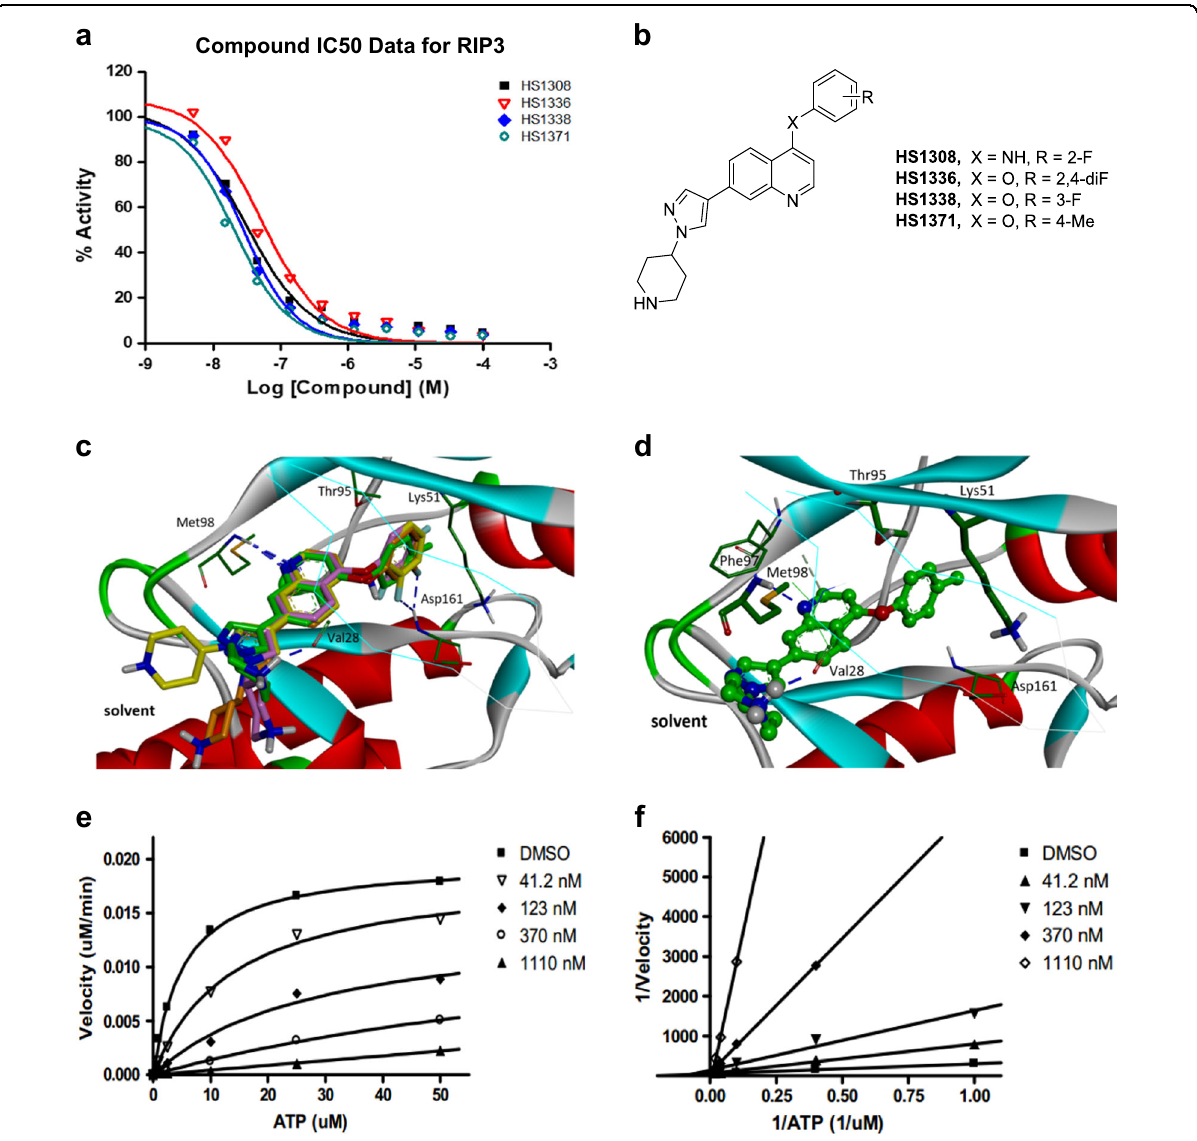
Fig. 1 Identi fi cation of HS-1371 as a novel RIP3 kinase inhibitor. a IC 50 curves for RIP3 with HS-1308, 1336, 1338, and 1371 treatments. b Chemical structures of HS-1308, 1336, 1338, and 1371. c , d . c Comparative view of the predicted binding conformations of HS-1308, 1336, 1338 and 1371 in the ATP-binding site of RIP3 (PDB ID: 4M66). Carbon atoms of HS-1308, 1336, 1338 and 1371 are colored in yellow, pink, brown, and green, respectively. d Detailed interaction patterns of HS-1371 in the ATP-binding site of RIP3. Hydrogen-bond interactions are represented with blue dotted lines. e , f . e Michaelis – Menten plot and f Lineweaver-Burk Plot for RIP3 with